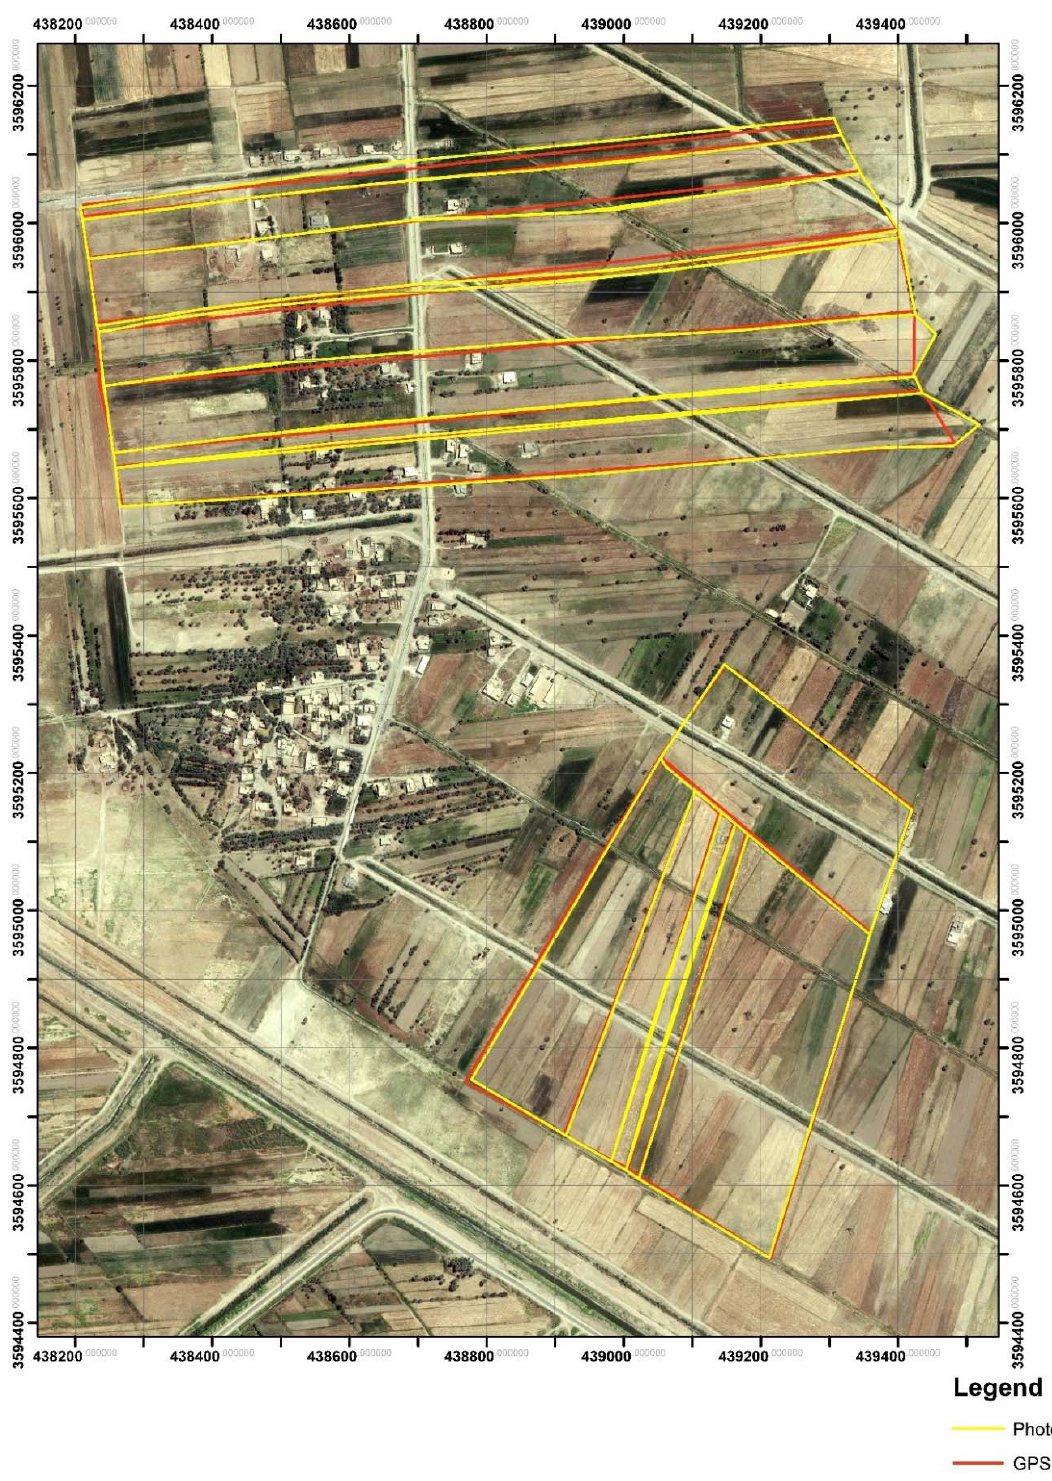
Figure 4. Aries rural area, near Al-Hillah. VGI-defined land parcel boundaries using two methods of delineation.